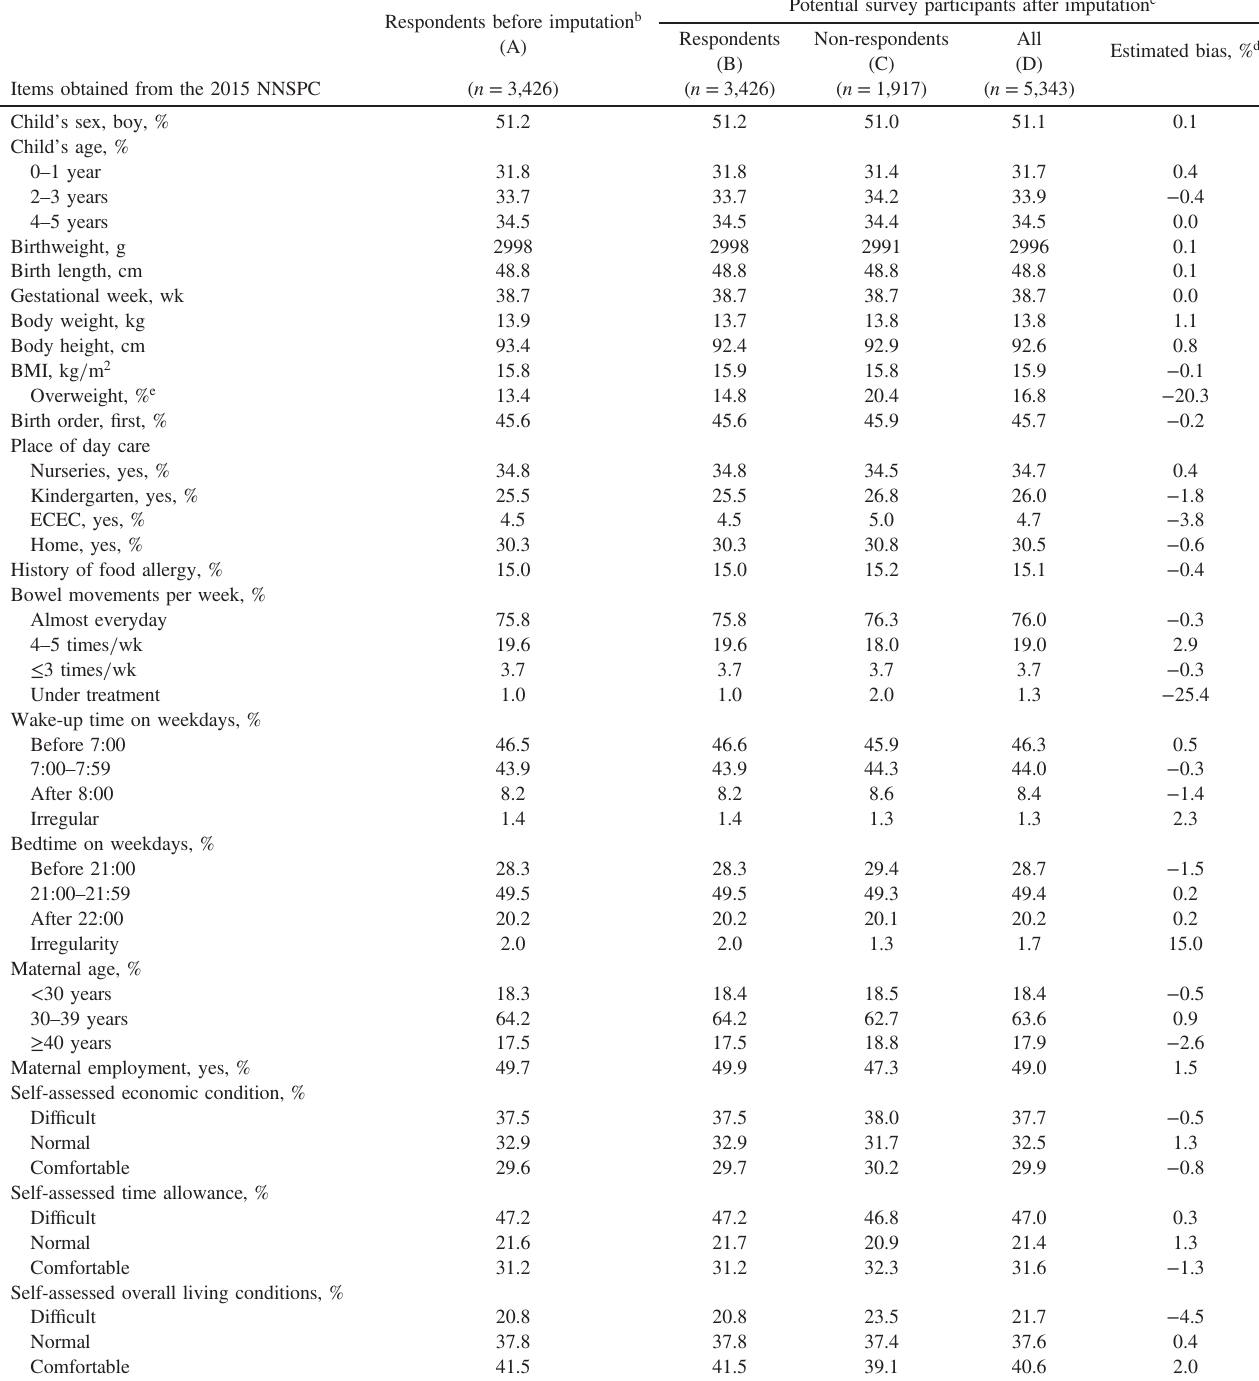
Table 3. Magnitude of bias in survey estimates among respondents of the 2015 National Nutrition Survey on Preschool Children, taking account of missingness through multiple imputation